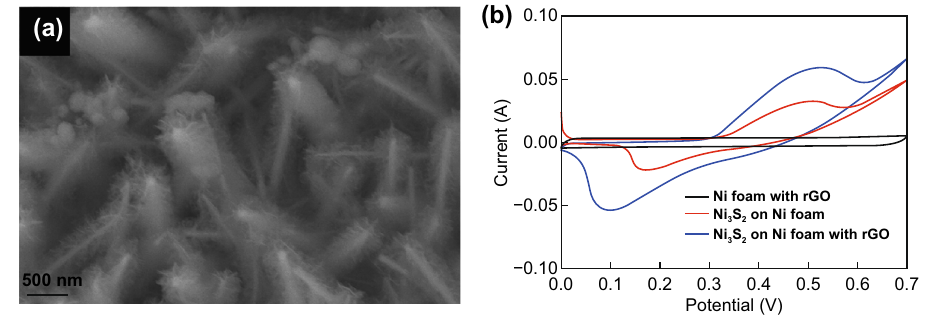
Fig. 9 a SEM image plume-like structure and b comparison of CV curves plume-like structure compared to rGO on NF and Ni 3 S 2 . Reproduced with permission from Ref. [133]. Copyright 2017, Elsevier